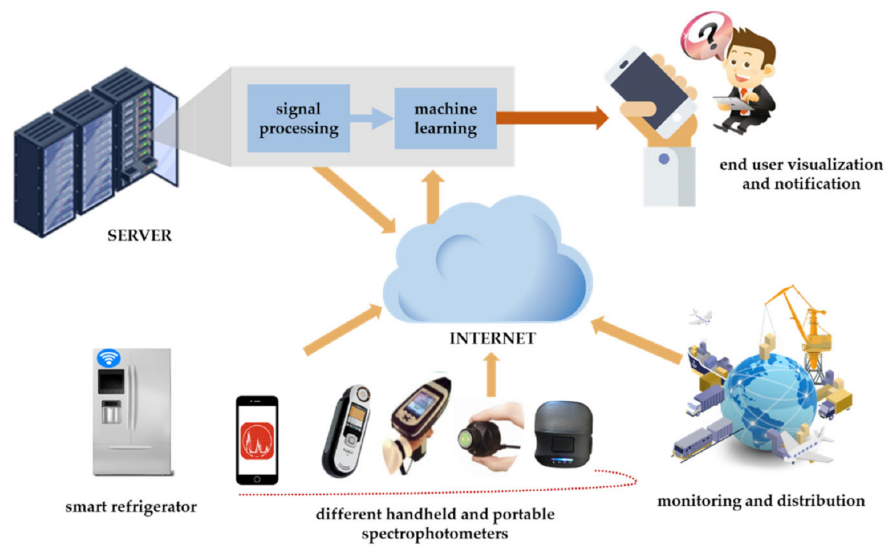
Figure 5. Flow diagram for the implementation of mobile diagnostics (based on Wijaya et al. [156]). Tellspec and Texas Instrument’s NIRScan nano scanners possess a wider spectral range (950–1630 nm) than both the fiber-optic NIRS (700 to 1050 nm) and SCiO TM (740 to 1070 nm), but a narrower range than the indico-pro NIRS (350 to 1800 nm). Tellspec,